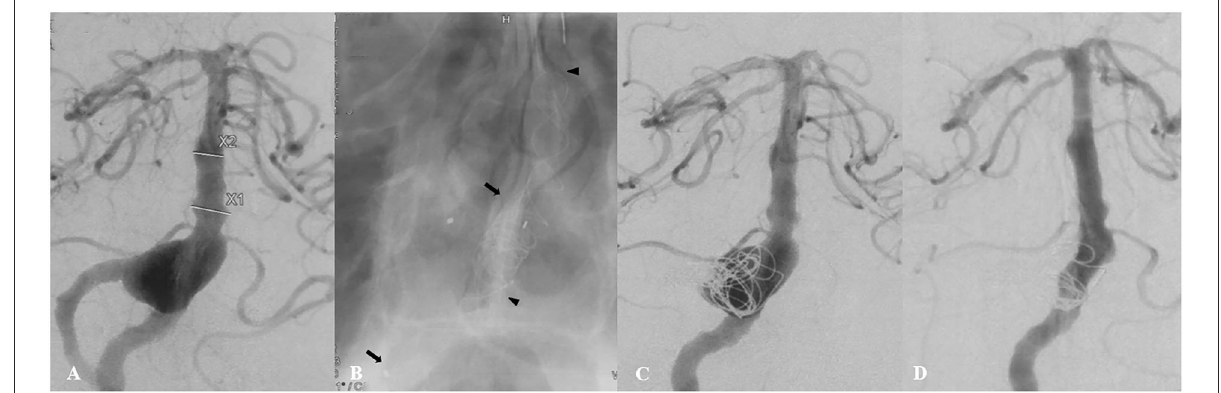
FIGURE1 A 46-year-old patient (Case 1) presented with a 2-month history of dizziness. Preoperative angiography showed a large fusiform vertebrobasilar junction aneurysm (A) . This patient underwent placement of two telescoping Tubridge devices (the arrow and the arrowhead), along with coiling and right vertebral artery sacrifice (B,C) . Follow-up angiography 12 months later showed complete aneurysm occlusion (D) .